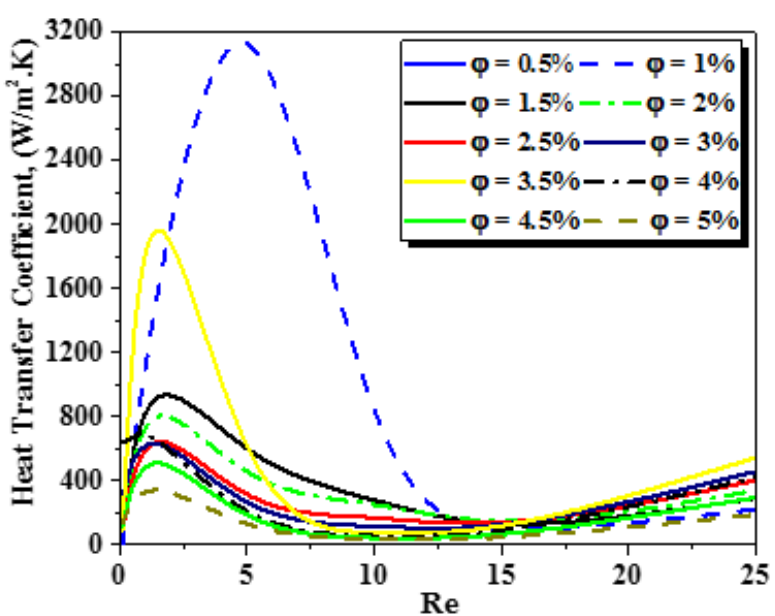
Figure 12. Evolutions of heat transfer coefficient for different generalized Reynolds numbers with various nanofluid concentrations ( ϕ = 0.5 to 5%).